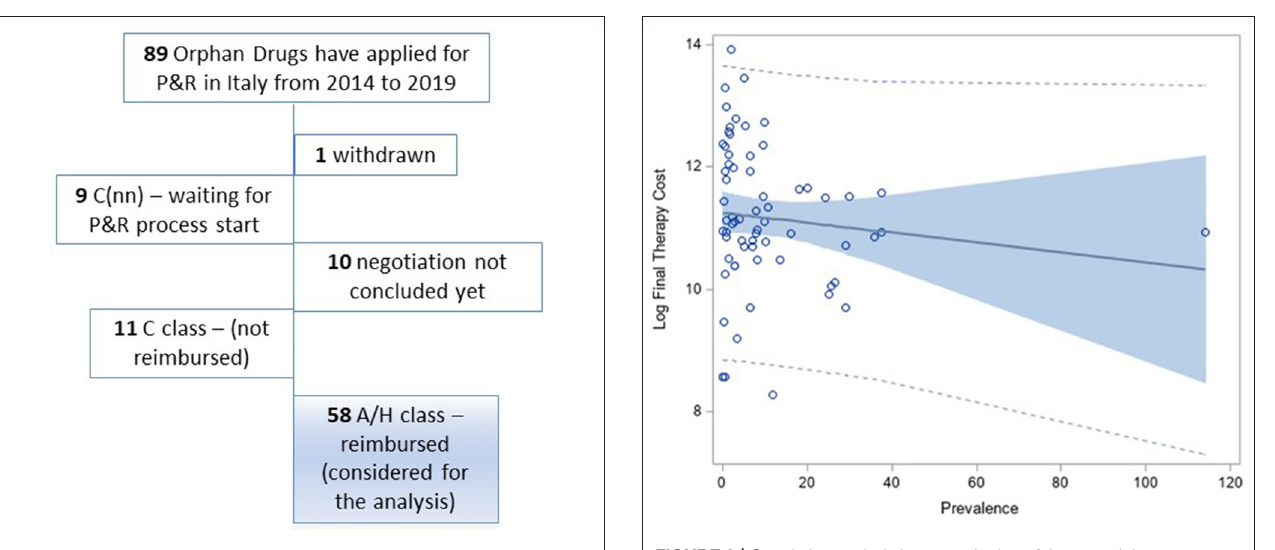
FIGURE 1 | Orphan drugs that applied for P&R in Italy in the period 2014–2019. Legend: A Class: Medicines reimbursed by the NHS. H Class: Medicines reimbursed by the NHS for inpatient use. C Class: Medicines not reimbursed by the NHS. C(nn) Class: Medicines waiting for P&R process, not reimbursed by the NHS.